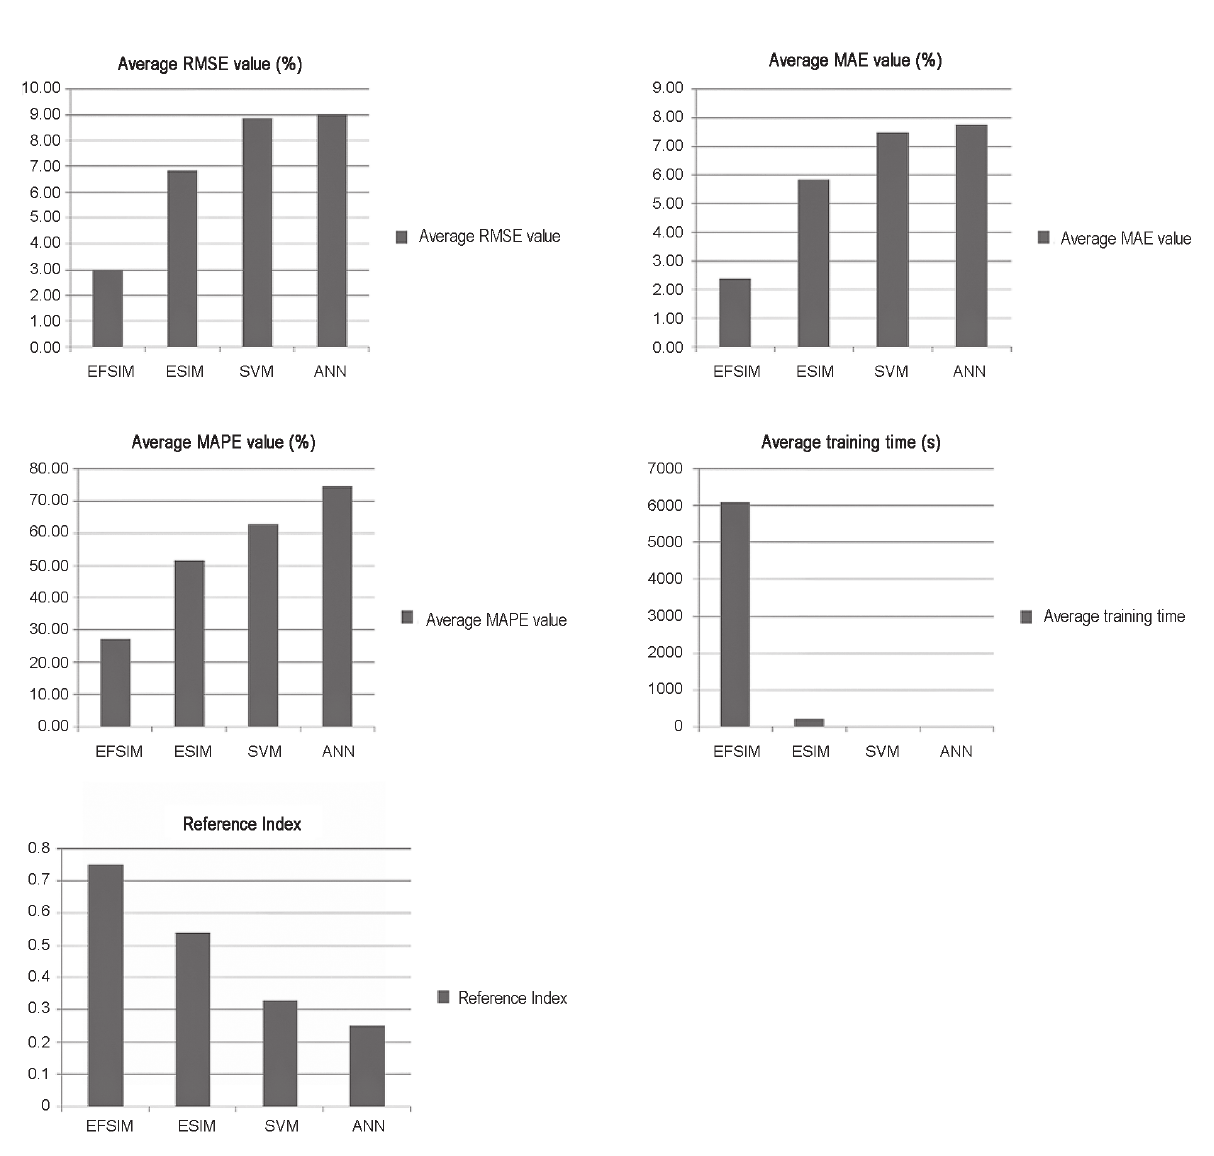
Fig. 8. Average result for performance measures with 10-fold